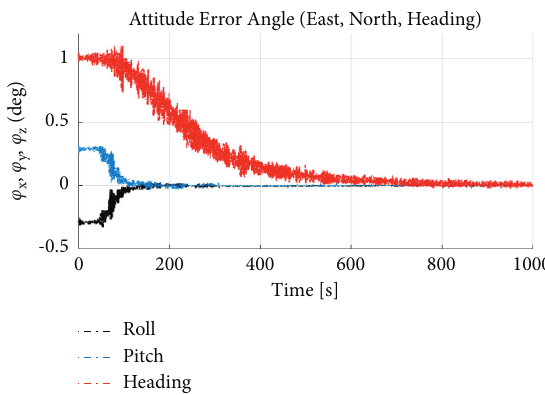
Figure 6: Estimation errors (East, North, and Heading).